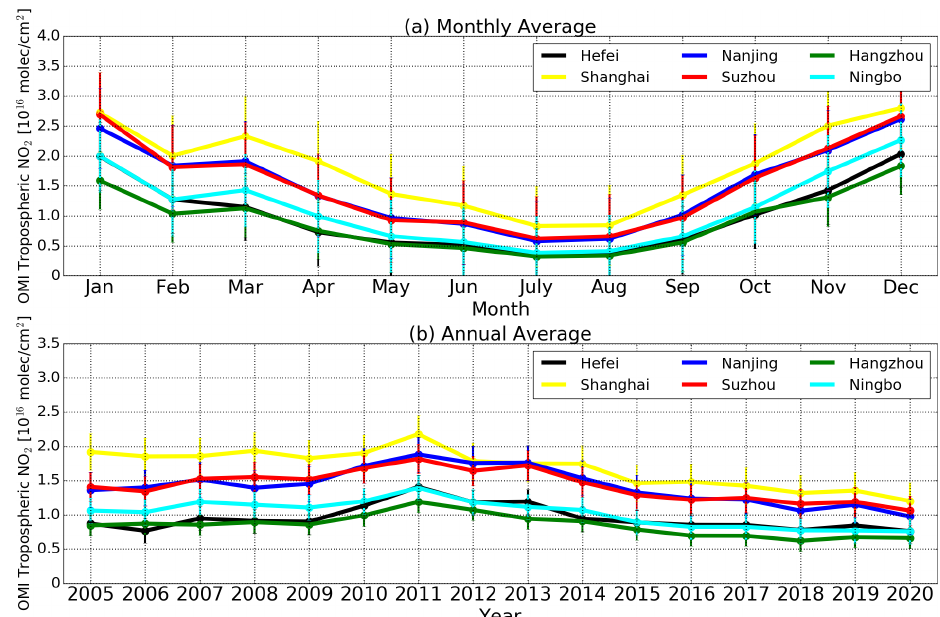
Figure 3. (a) Monthly averaged NO 2 VCD trop over Hefei (black dots and lines), Nanjing (blue dots and lines), Shanghai (yellow dots and lines), Suzhou (red dots and lines), Hangzhou (green dots and lines), and Ningbo (cyan dots and lines). (b) Same as (a) but for annual average. The vertical error bar is 1 σ standard variation within that month or